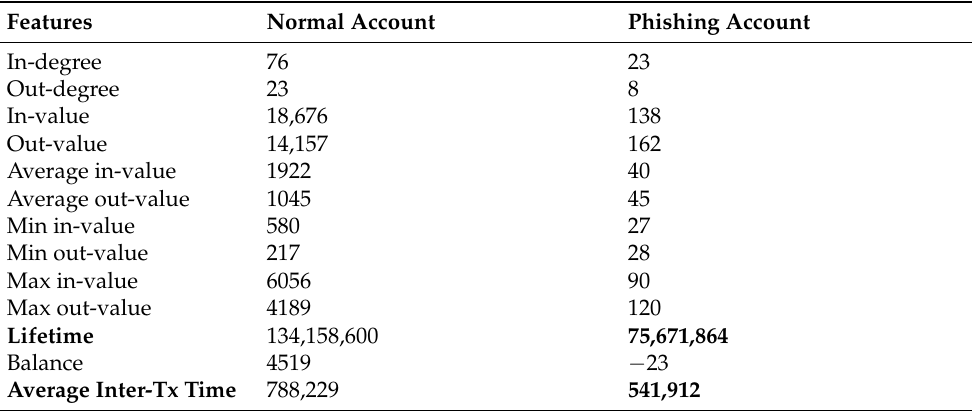
Table 5. The average value of account node features. The result shows that phishing accounts have the most notable differences in temporal features such as the lifetime and the average interval of transactions indicated in